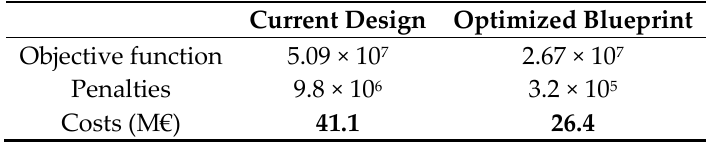
Table 3. Obtained results for the current design and the optimized